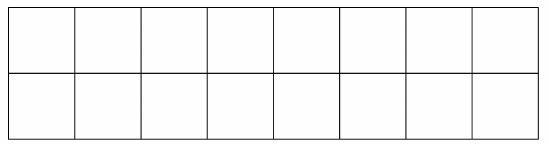
Figure 21. Discretized model of the 2D cantilever beam subjected to a harmonic